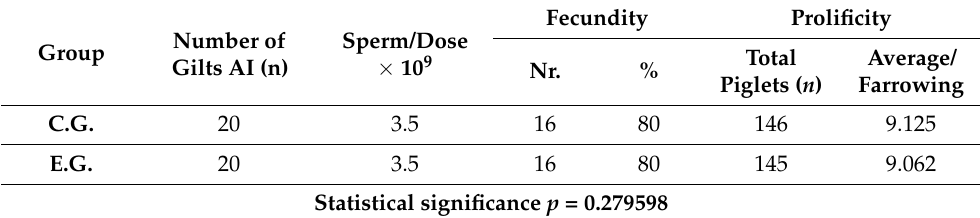
Table 7. Fertility and prolificity of AI sows with fluconazole additive